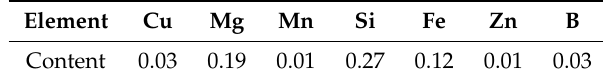
Table 1. Chemical composition of the 6101 aluminum foam in weight percent (wt.%). Data from Zhou et al.